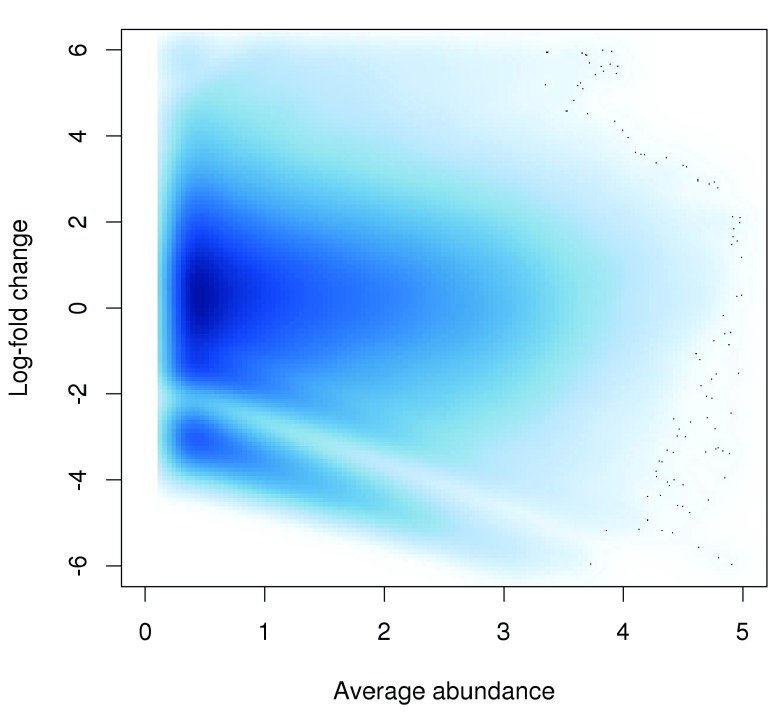
Effect of non-linear normalization on the trended bias between two H3K9ac libraries.Normalized log-fold changes are shown for all windows retained after filtering.